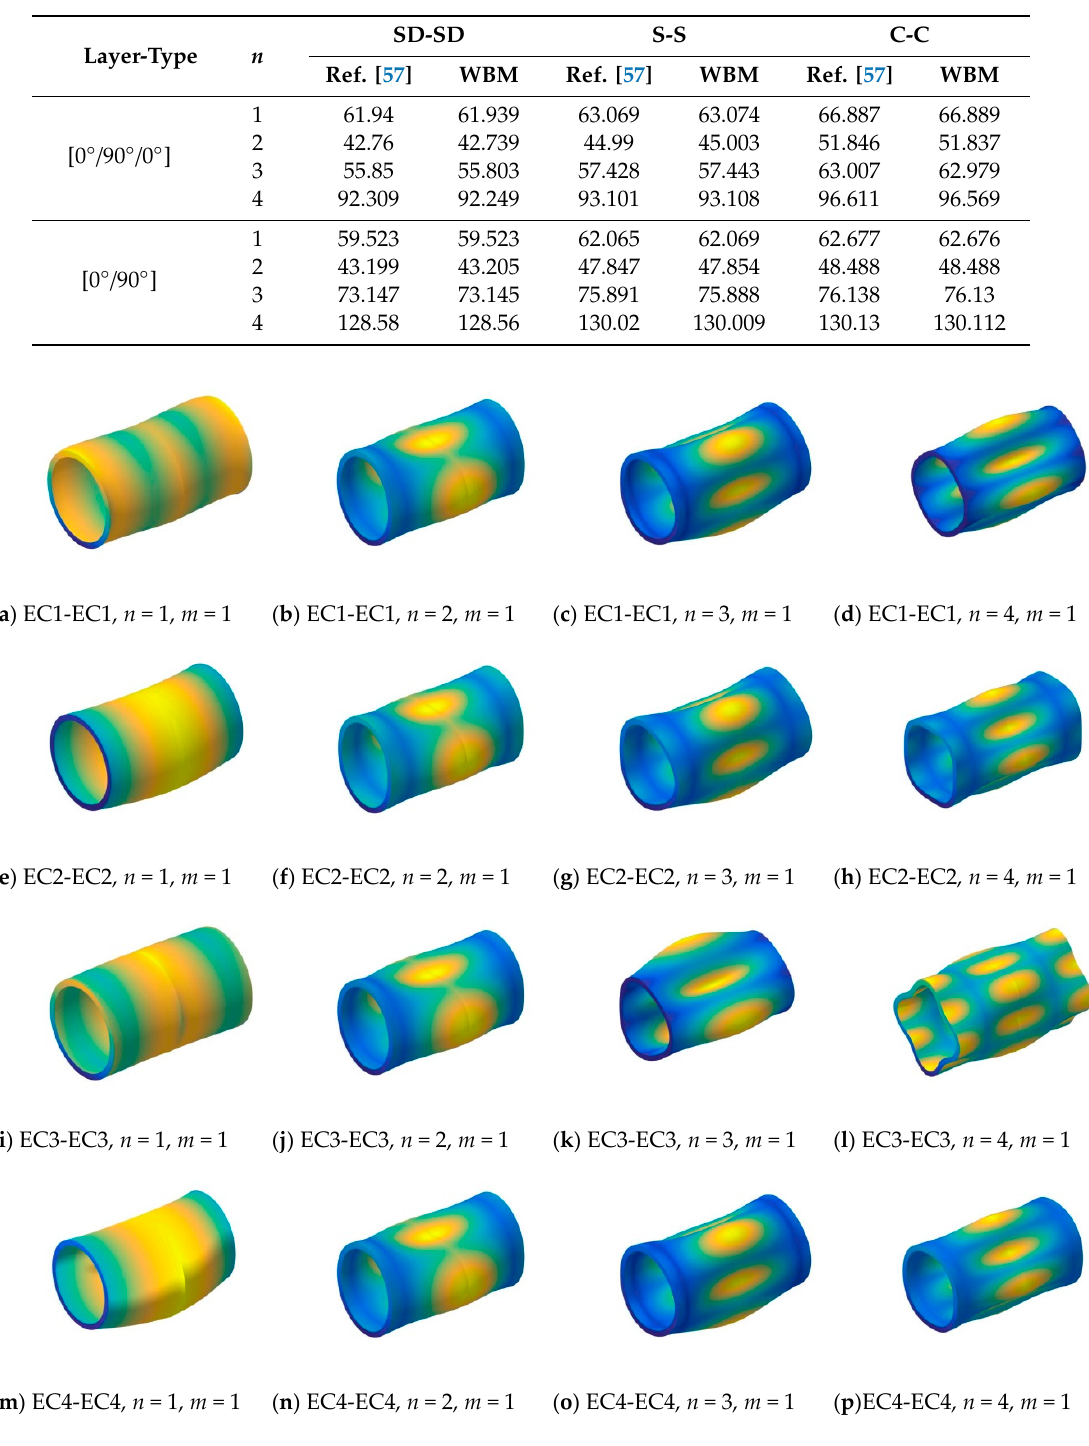
(cid:112) ρ Table 6. Frequency parameters Ω = ω L 2 / E 2 / h for two types of cross-ply composite laminated cylindrical shells with classical boundary conditions ( L / R = 4, h / R = 0.1, E 2 = 2 GPa, E 1 / E 2 = 25,